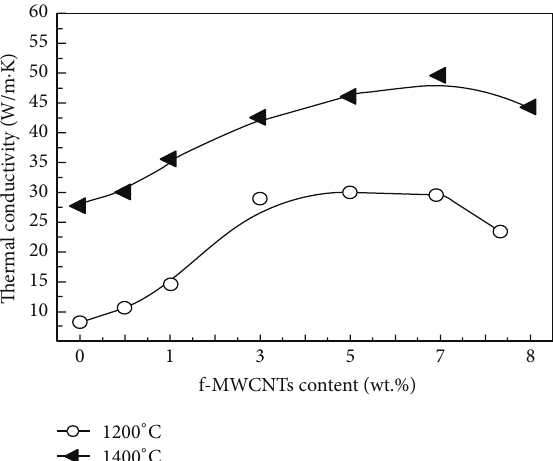
Figure 11: Thermal conductivity data of nanocomposites.